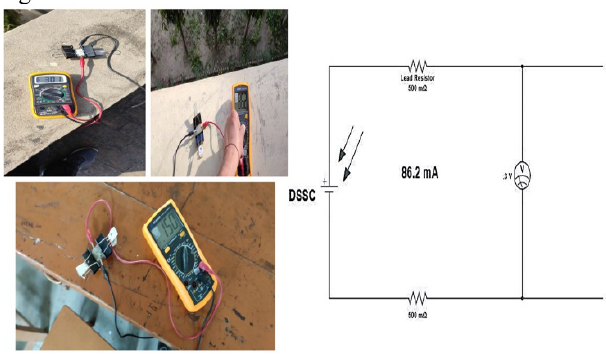
Figure 7. Experimental set up of the cell for